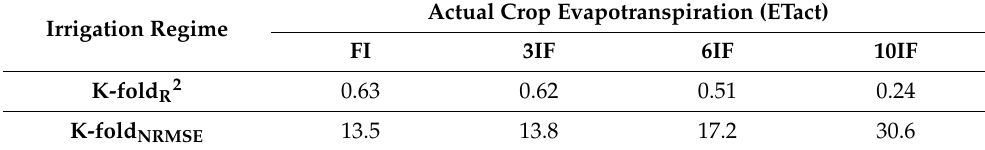
Table 6. K-fold cross-validation results (5